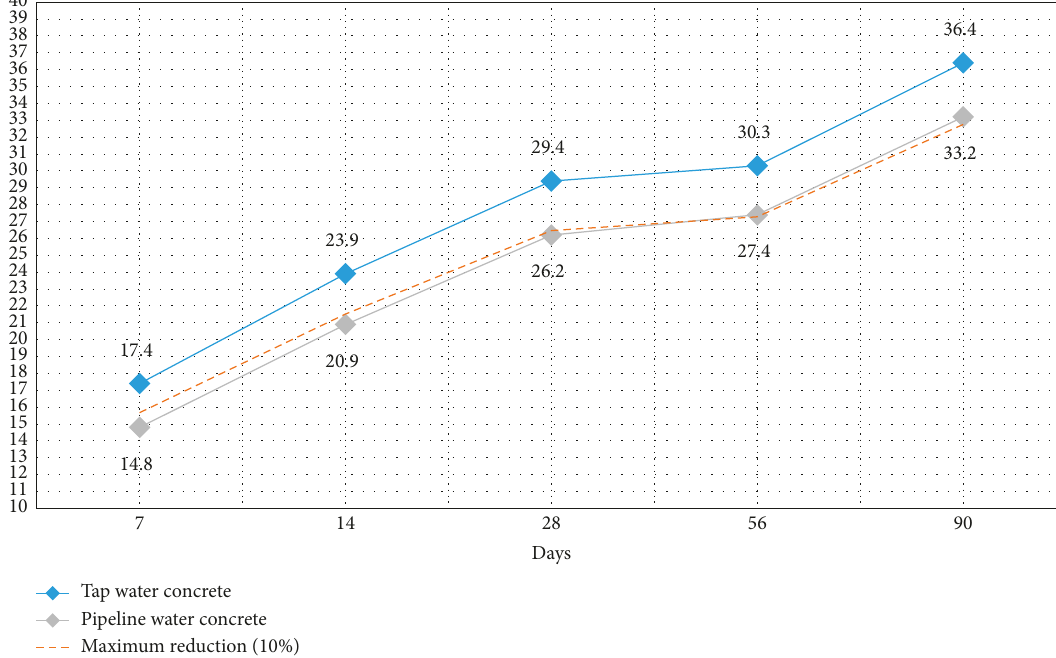
Figure 11: Comparative chart of compressive strength results for normal concrete samples made by using tap water and pipeline